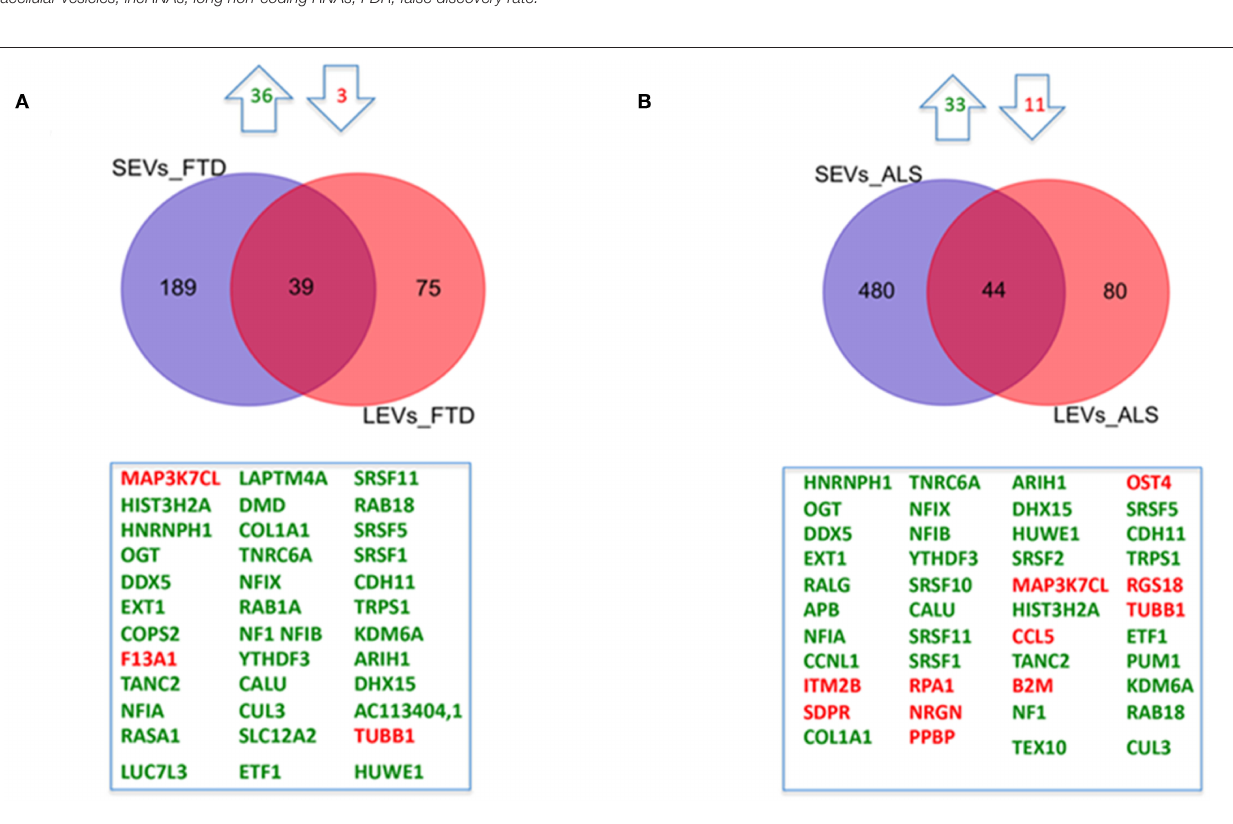
Frontiers in Aging Neuroscience |